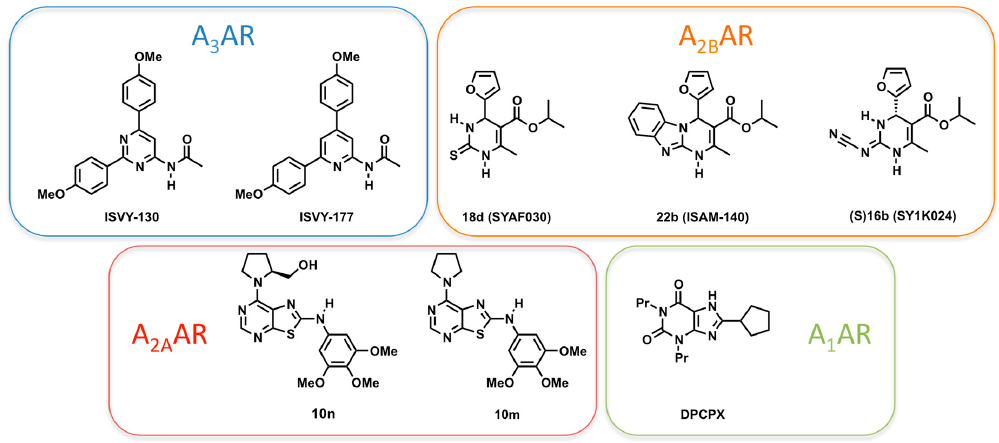
Figure 1. Adenosine receptor antagonists discussed in this work.